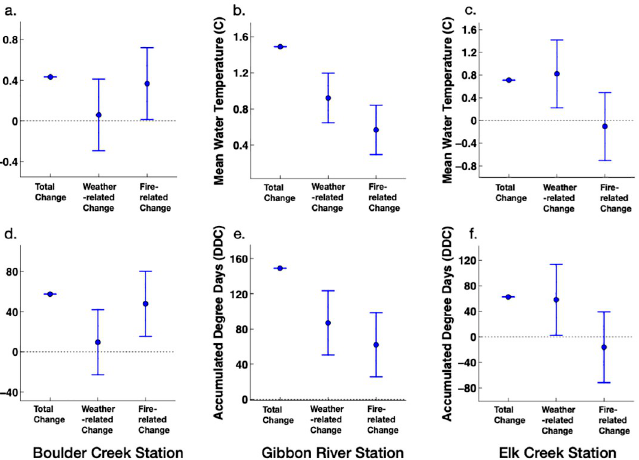
Fig 7. Weather and wildfire contributions on the post-fire change in the summer mean water temperature and accumulated degree days at (a, d) Boulder Creek, (b, e) Gibbon River, and (c, f) Elk Creek stream sites. Filled circles represent point estimates and the bars signify the 95% confidence intervals (1.96 x